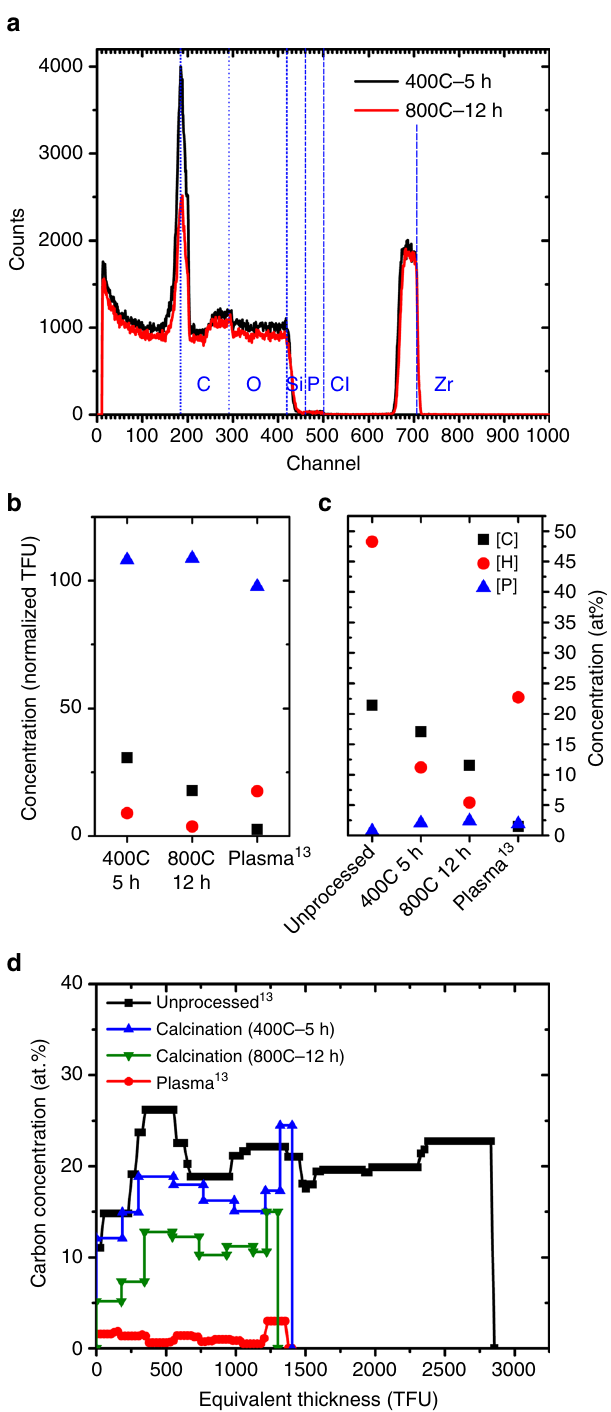
Fig. 3 Chemical characterization after calcination and plasma processing. a Non-Rutherford elastic backscattering (EBS) spectra of the ZrO 2 CNAs after calcination at 400 °C for 5 h and 800°C for 12 h, showing signi fi cant carbon content (channel 185). b Concentration of C, H, and P in the fi lms during calcination at 400 °C for 5 h, 800 °C for 12 h and plasma processing 13 , normalized with respect to concentration in unprocessed CNAs. c Concentration of C, H, and P in the unprocessed fi lms, during calcination and plasma processing 13 , in at%. d Depth pro fi le of the carbon concentration (in at.%) after calcination and plasma processing